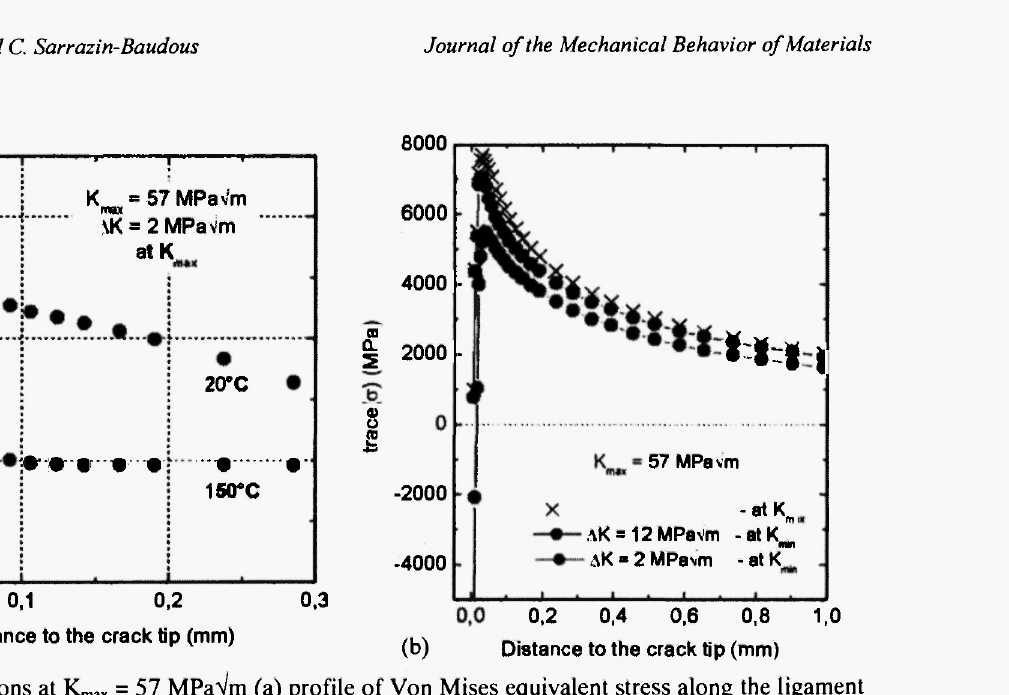
F.E. simulations at K max = 57 MPaVm (a) profile of Von Mises equivalent stress along the ligament at 20°C and 150°C at K max (b) profile of the stress tensor trace along the ligament at K max and K min for ΔΚ = 2 or 12